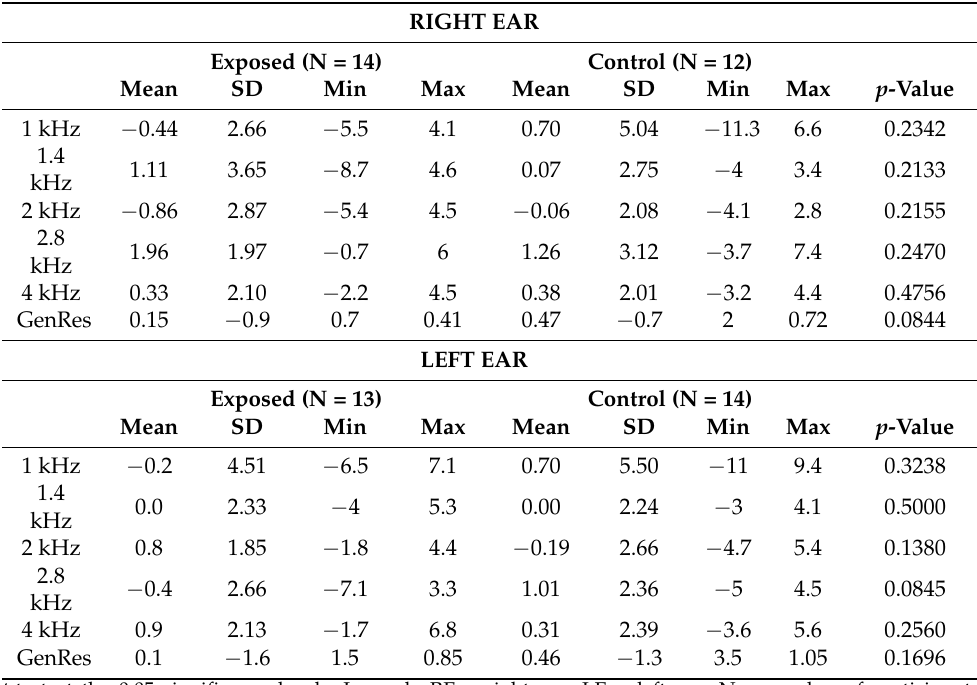
Table 6. Descriptive statistics of the TEOAE suppression effect at the frequencies of 1 kHz, 1.4 kHz, 2 kHz, 2.8 kHz, and 4 kHz, and general response of the exposed and control groups per